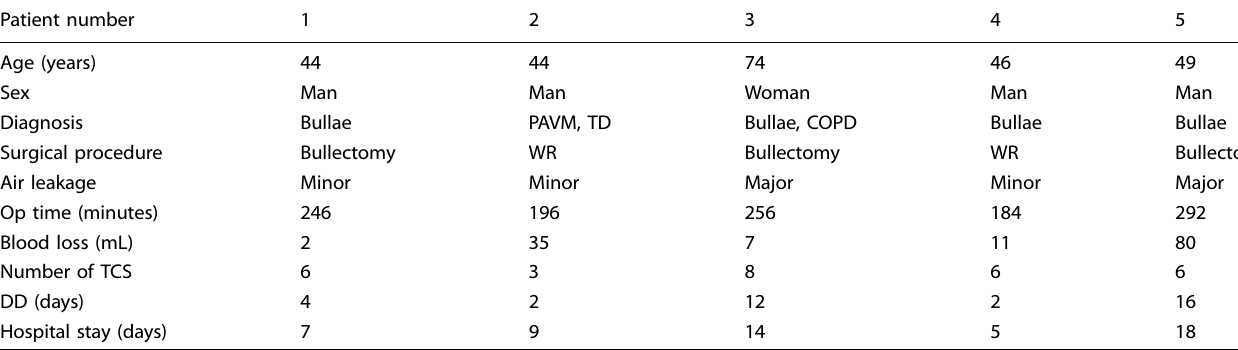
Table 5. Clinical characteristics, operative characteristics, and outcomes.